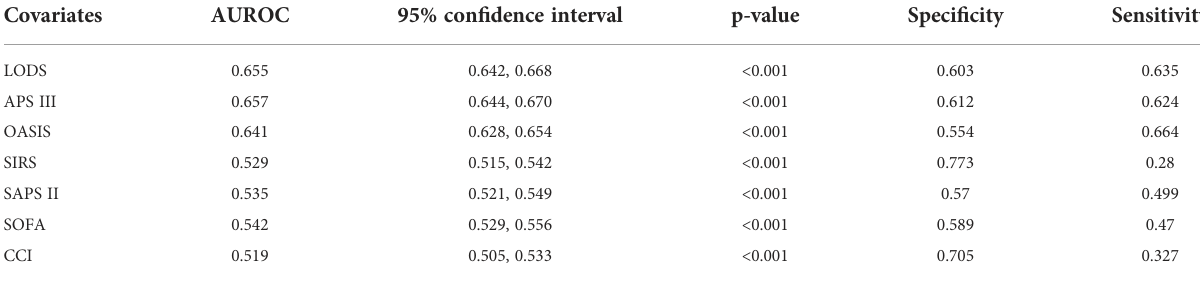
LODS,LogisticOrganDysfunctionScore;APSIII,AcutePhysiologyScoreIII;OASIS,OxfordAcuteSeverityofIllnessScore;SIRS,SystemicIn fl ammatoryResponseSyndromeScore;SAPS II, Simpli fi ed Acute Physiology Score II; SOFA, Sequential Organ Failure Assessment; CCI, Charlson Comorbidity